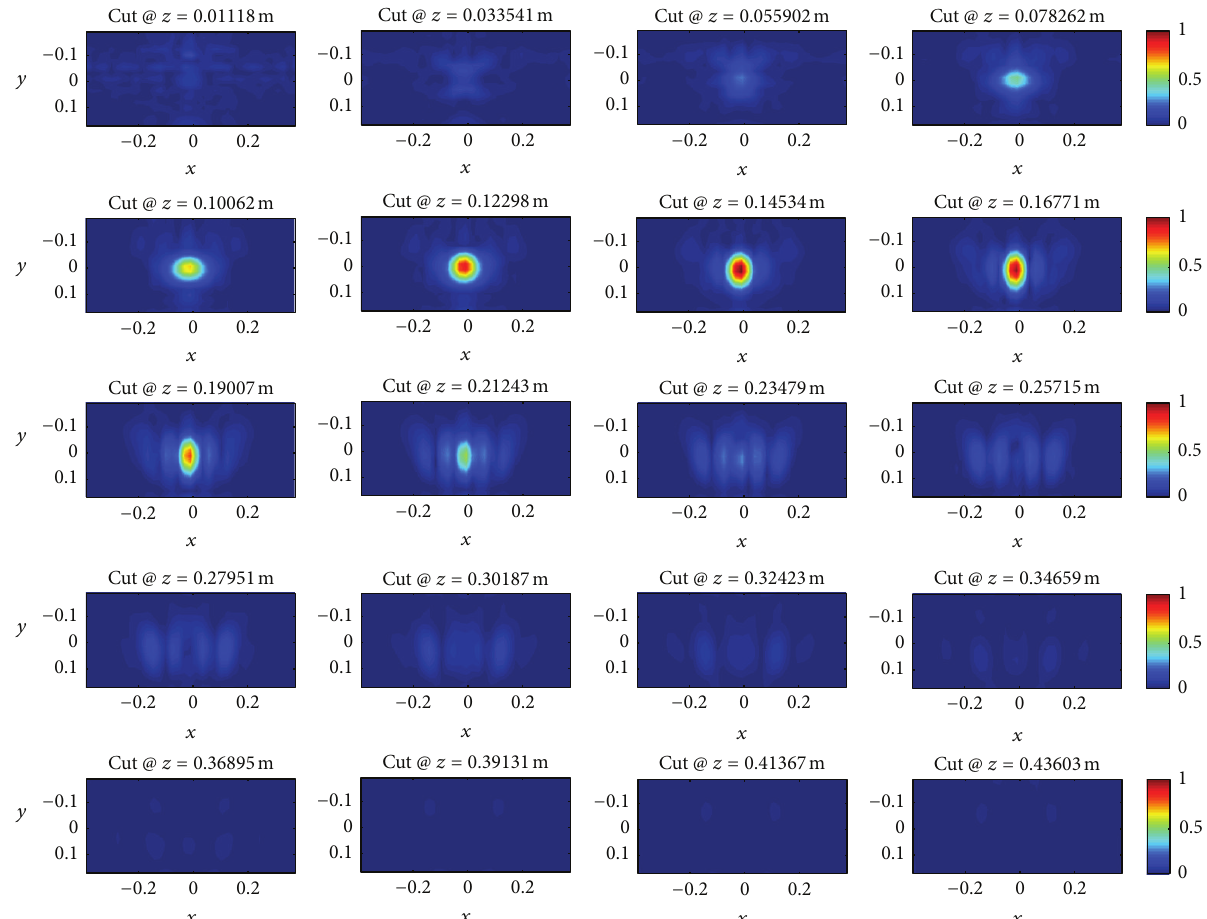
Figure 8: Depth slices of the contrast function reconstructed by processing the data set referred to a vacuum cube as in Figure 4.